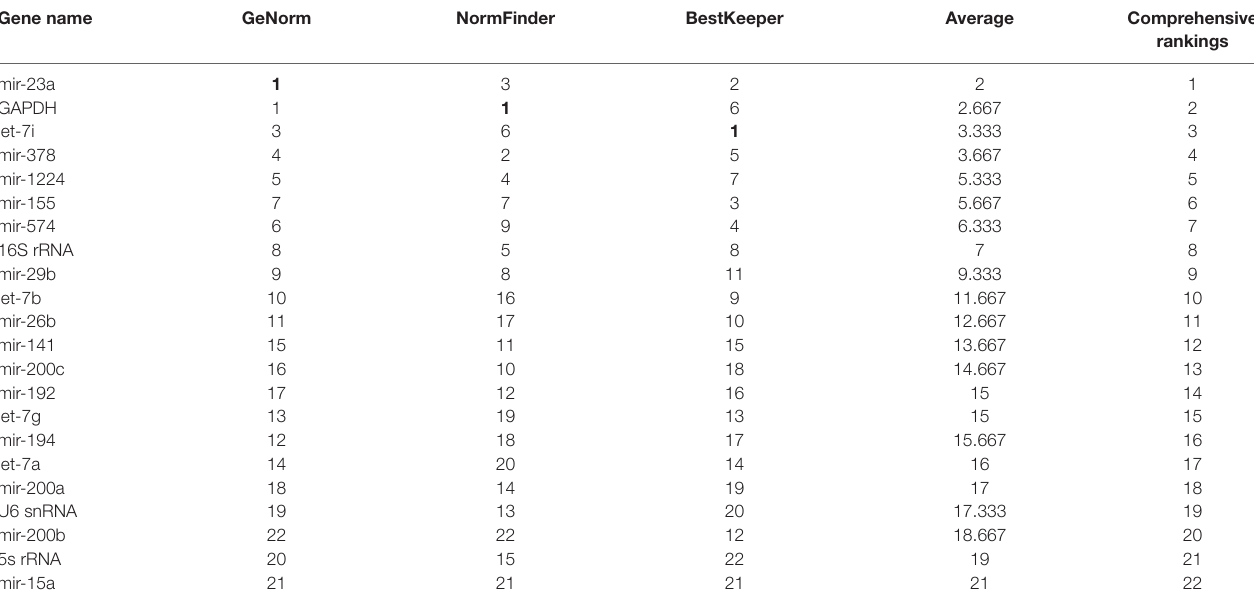
TABLE 1 | The overall ranking of expression stability for candidate reference genes. Gene